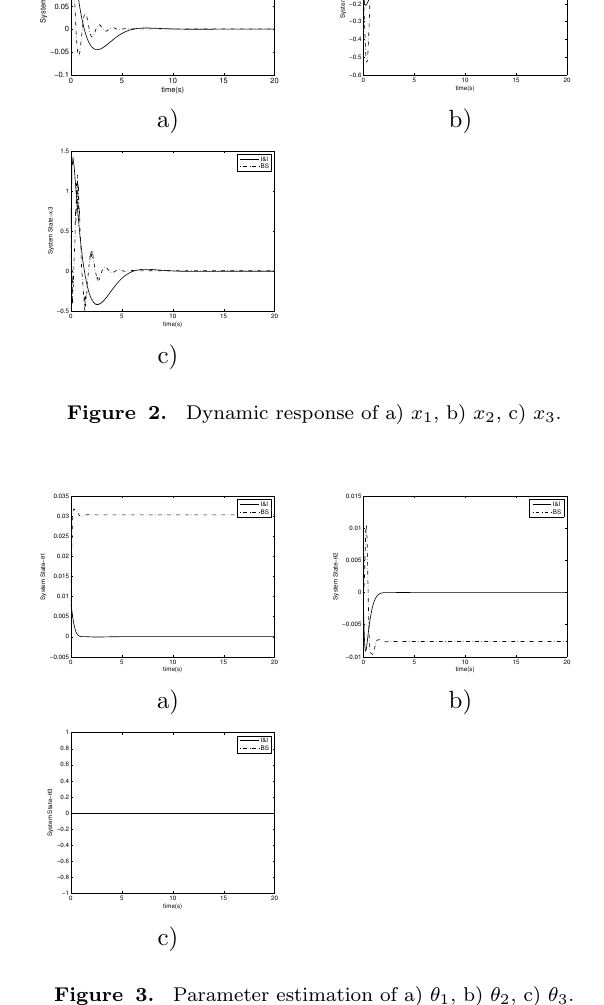
Figure 3. Parameter estimation of a) θ 1 , b) θ 2 , c) θ 3